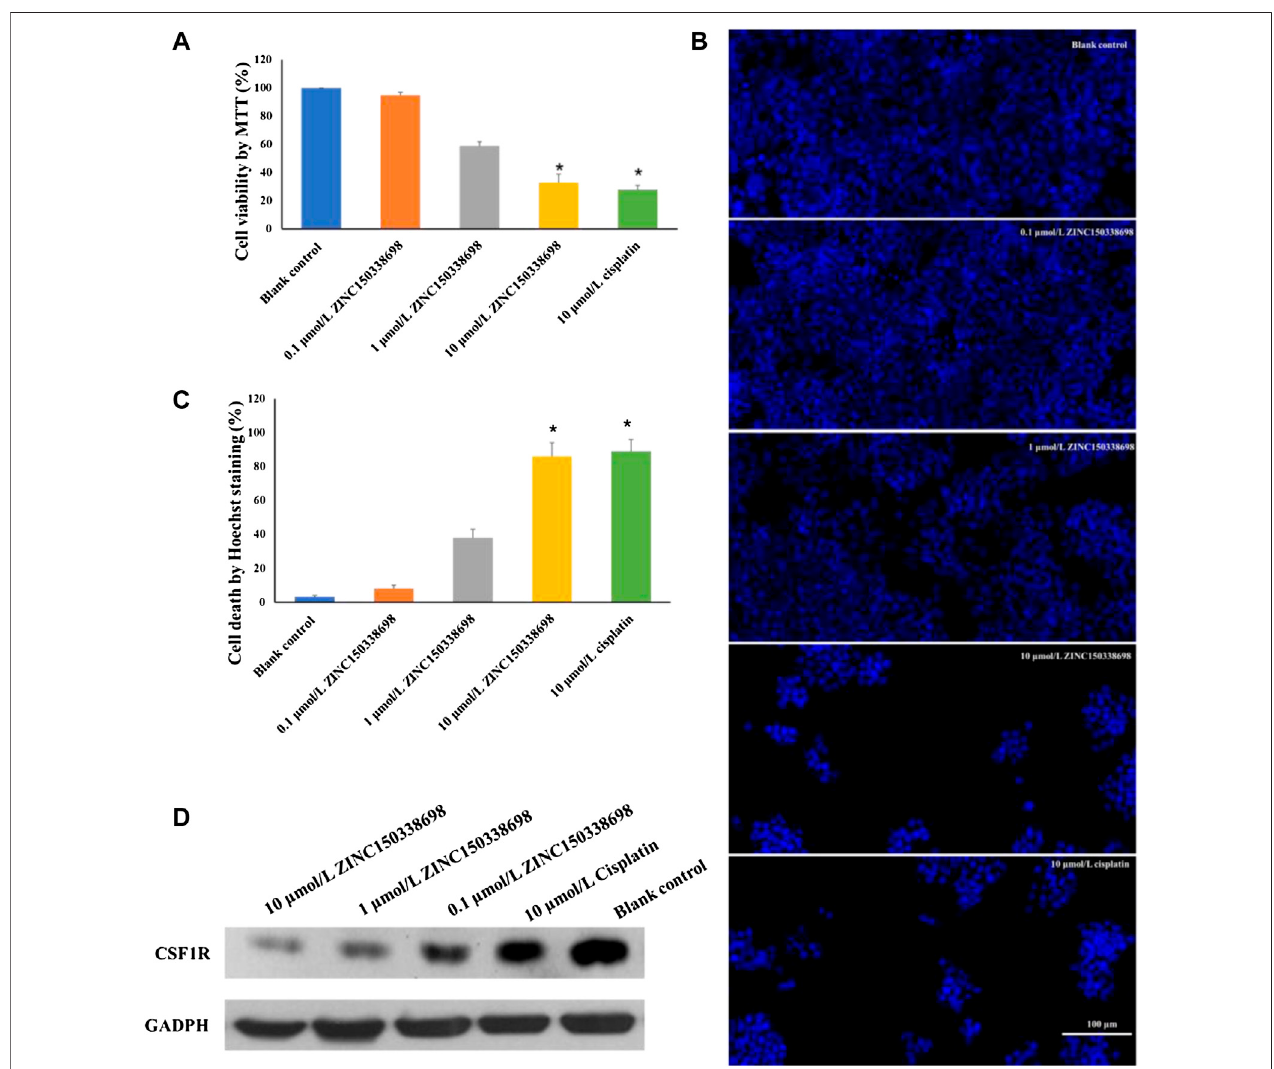
FIGURE 4 | (A) Viability of MG-63 cells was detected by MTT assay. The cell growth was signi fi cantly inhibited by 10 μ mol/L ZINC150338698 at 48 h. (B) Percentage of cell death according to Hoechst staining at 48 h. Compared with the blank control group, * p < 0.05. (C) Expression of CSF1R in MG-63 cells after treatment at 48 h; GADPH was set as a positive control. (D) Corresponding gray-scale value of CSF1R based on GAPDH, compared with the blank control group, * p <